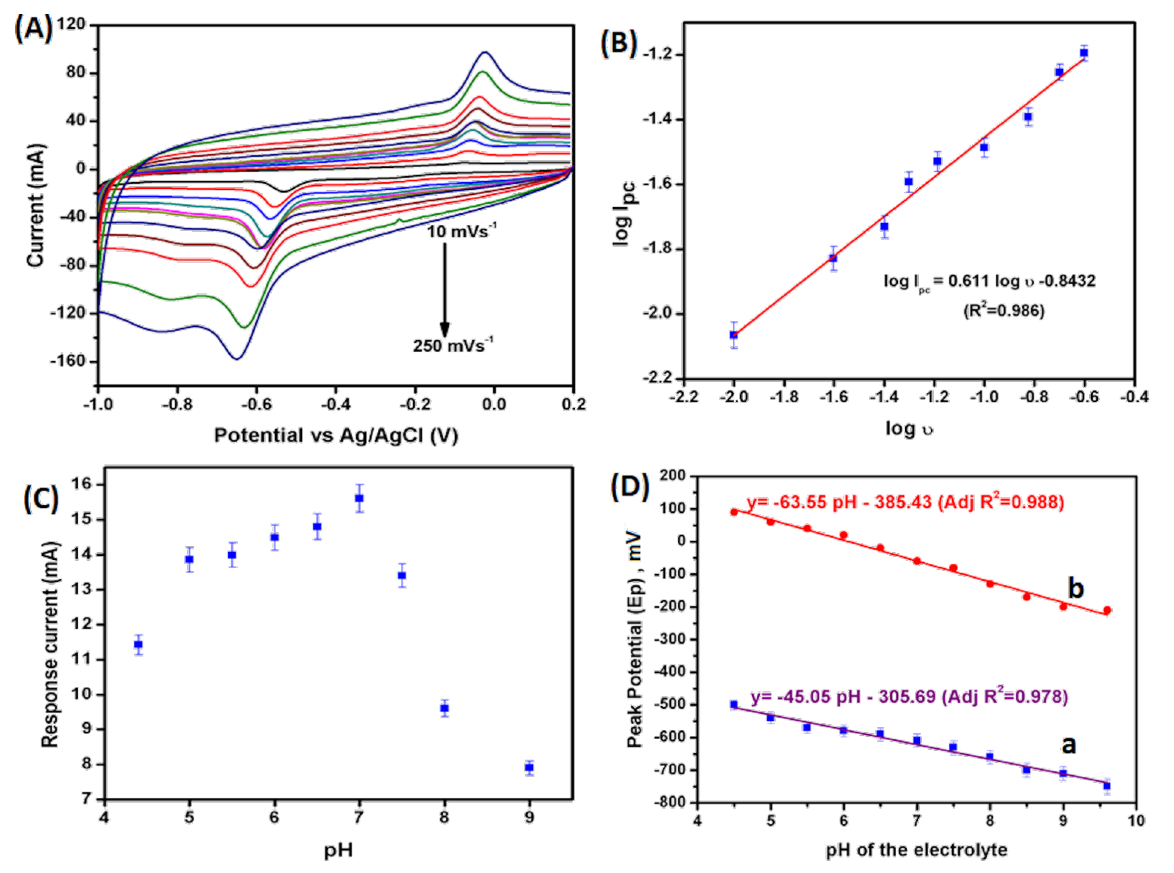
Figure 7: (A) Cyclic voltammograms of ERGO/GCE under different scanning rates (10, 25, 40, 50, 65, 80, 100, 125, 150, 200, 250 mV·s − 1 ) in PBS, pH 7, containing 10 μ M PT. (B) Plot of the logarithm value of the reduction peak current as a function of the scanning rate (log I pc as a function of log ν ). (C) Plot of the reduction peak current of PT as a function of electrolyte pH. (D) Plot for the reduction (a) and oxidation (b) peak potential of PT (40 μ M PT) as a function of the electrochemical cell pH, scan rate: 100 mV·s − 1